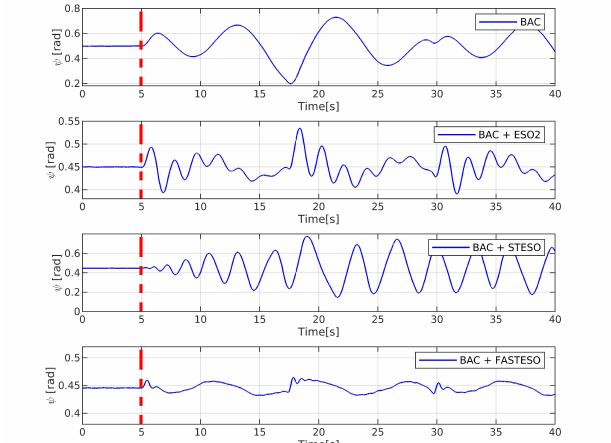
Figure 14. Results of angular rate ω y with unknown external torque disturbance under backstepping controller combined with nothing, ESO2, STESO and FASTESO.